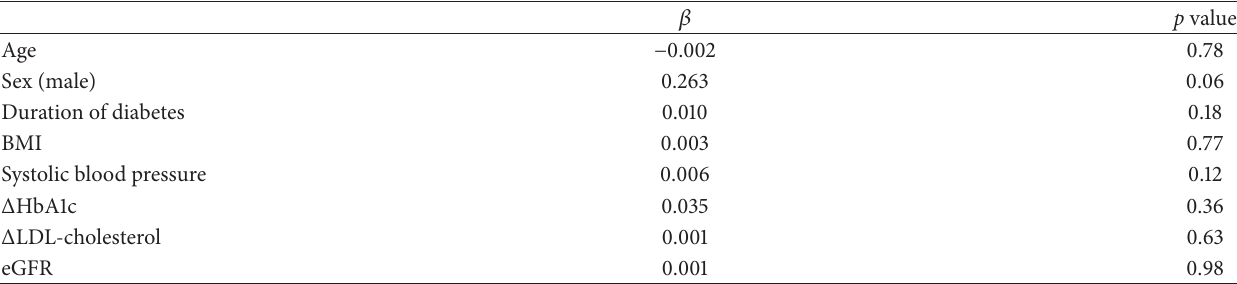
Table 3: Multiple linear regression analysis for predictors of change of